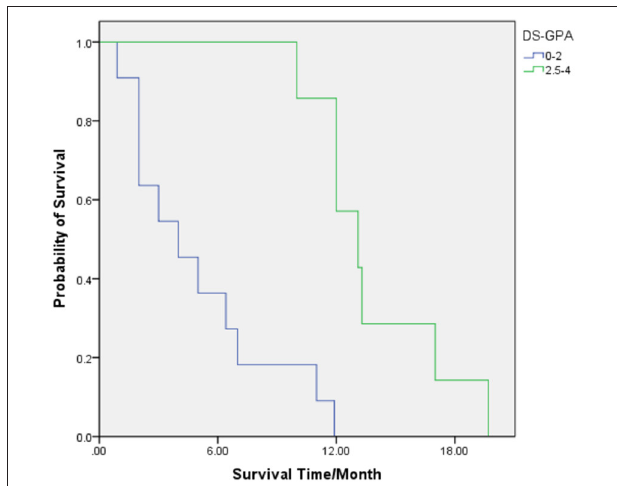
FIGURE 3 | OS for patients with diagnosis-specific Graded Prognostic Assessment (DS-GPA) scores of 0–2 (Green) and 2.5–4